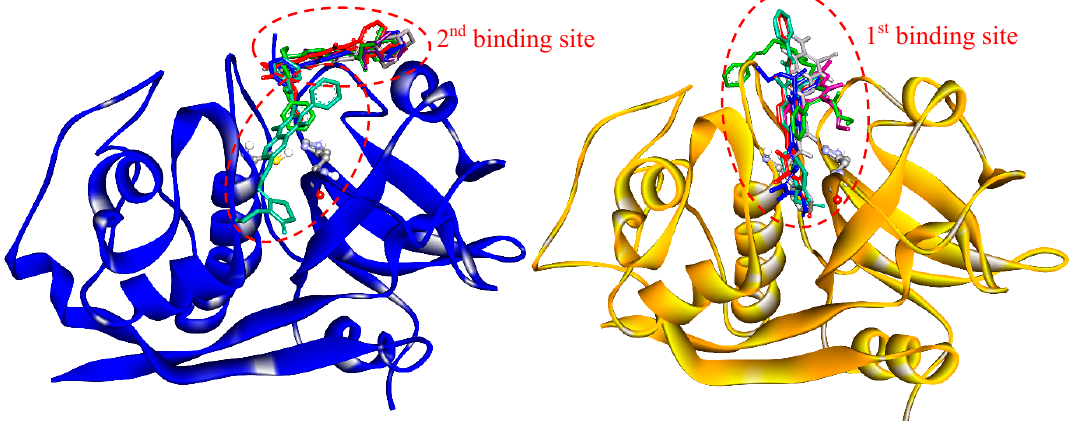
Figure 6. Binding sites of quinoxaline 1,4-di- N -oxide derivatives as predicted by molecular docking. Enzymes are represented in the new cartoon ( Fh CL1 in blue and Fh CL3 in orange), the most representative clusters for the six-hit compounds are shown in sticks and the catalytic dyad in balls and sticks.